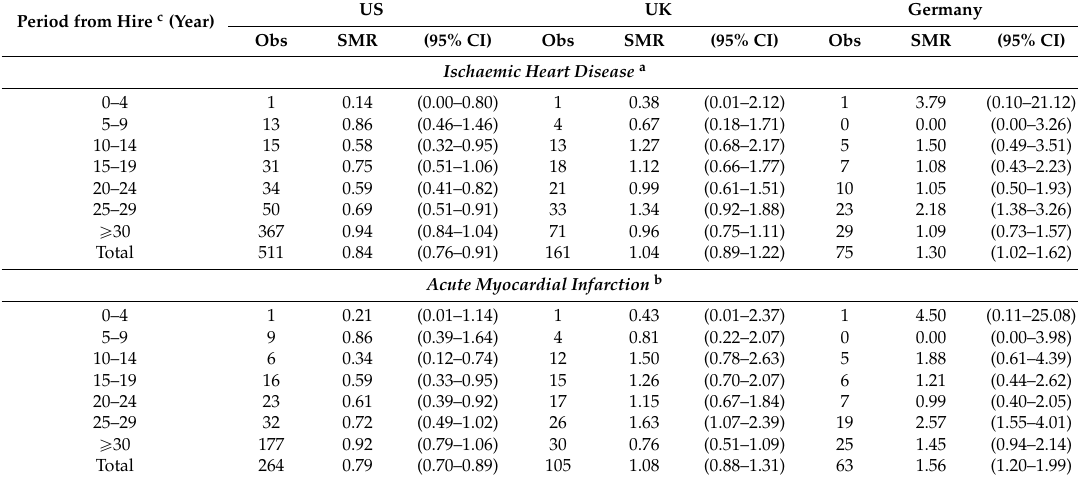
Table 3. Standardised mortality ratios (SMRs) based on national rates for cardiac a,b mortality by period from hire, in carbon black production workers (full cohorts).